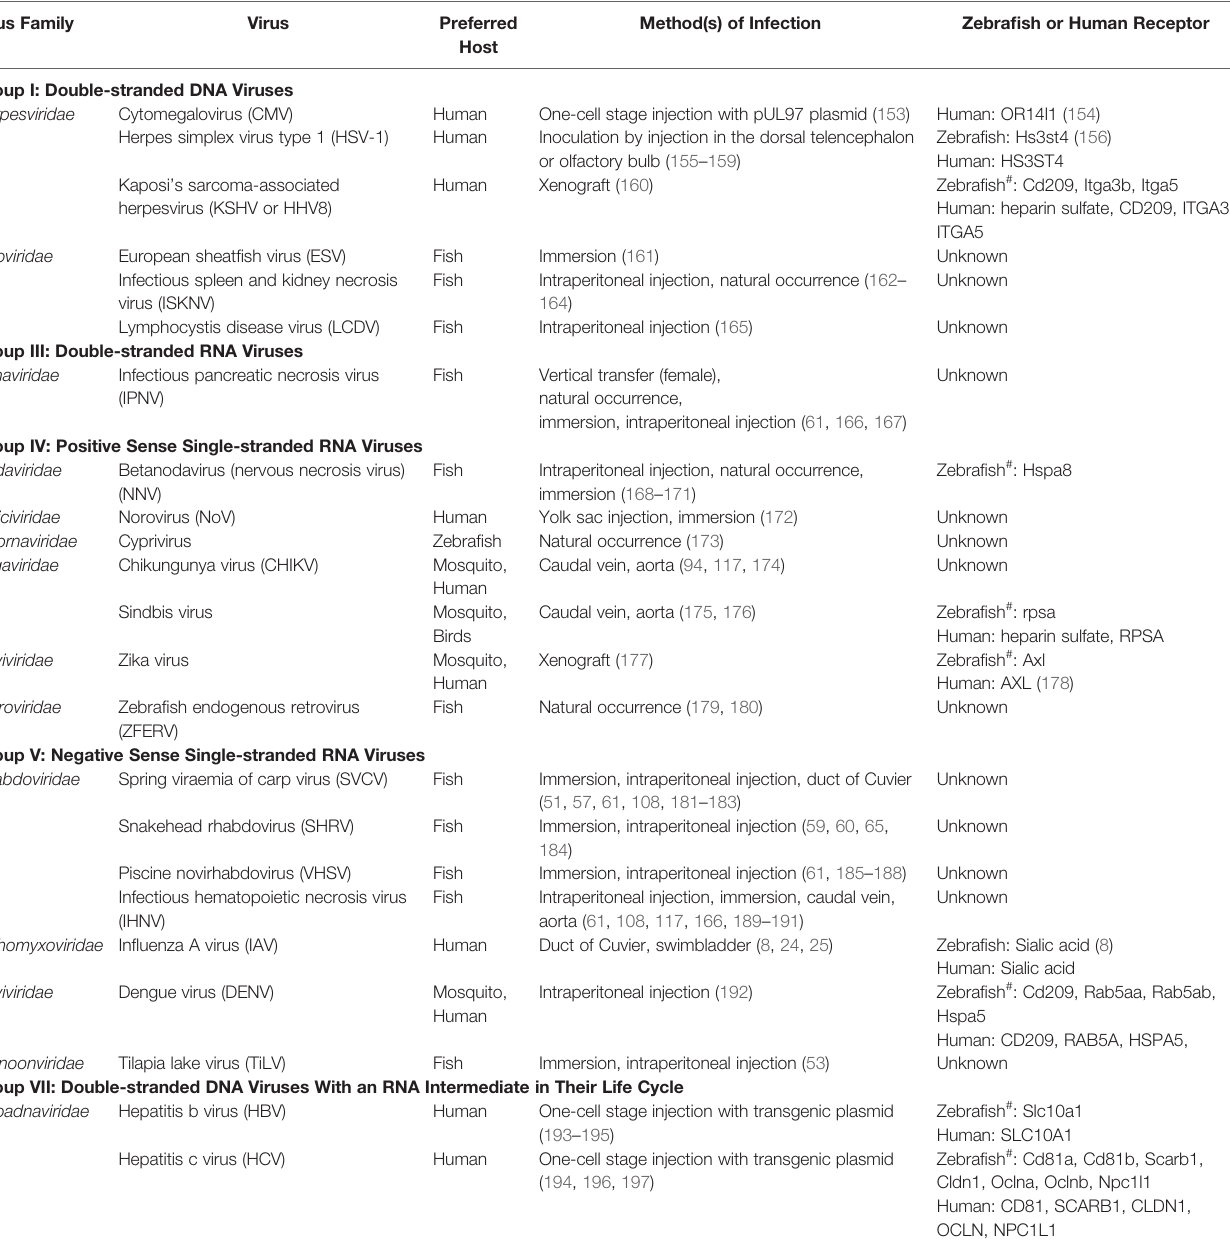
TABLE 5 | Viruses studied in zebra fi